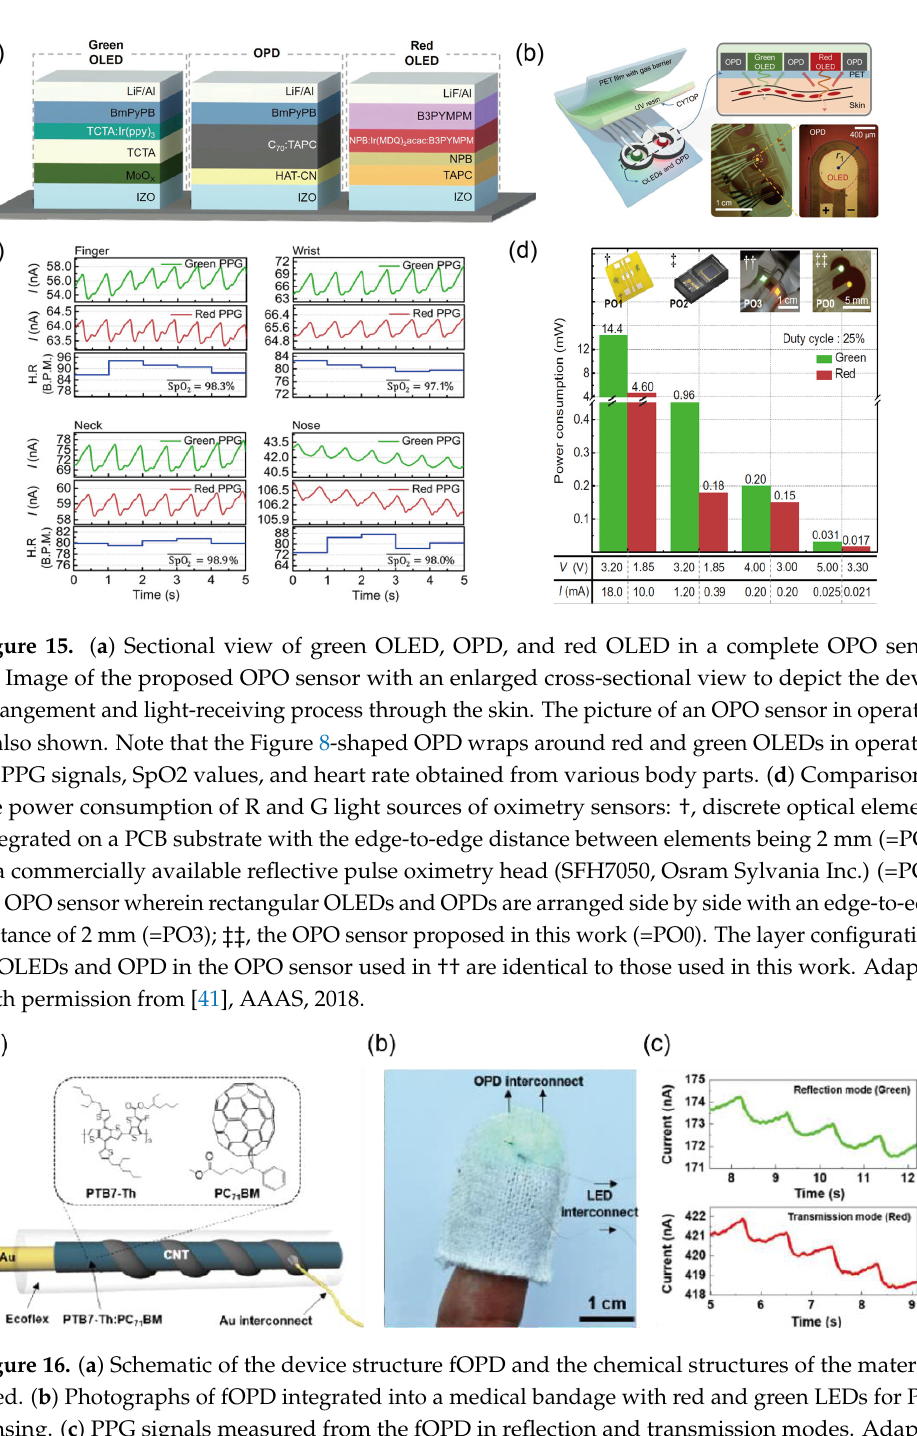
Figure 16. ( a ) Schematic of the device structure fOPD and the chemical structures of the materials used. ( b ) Photographs of fOPD integrated into a medical bandage with red and green LEDs for PPG sensing. ( c ) PPG signals measured from the fOPD in reflection and transmission modes. Adapted with permission from [42], ACS Publications,